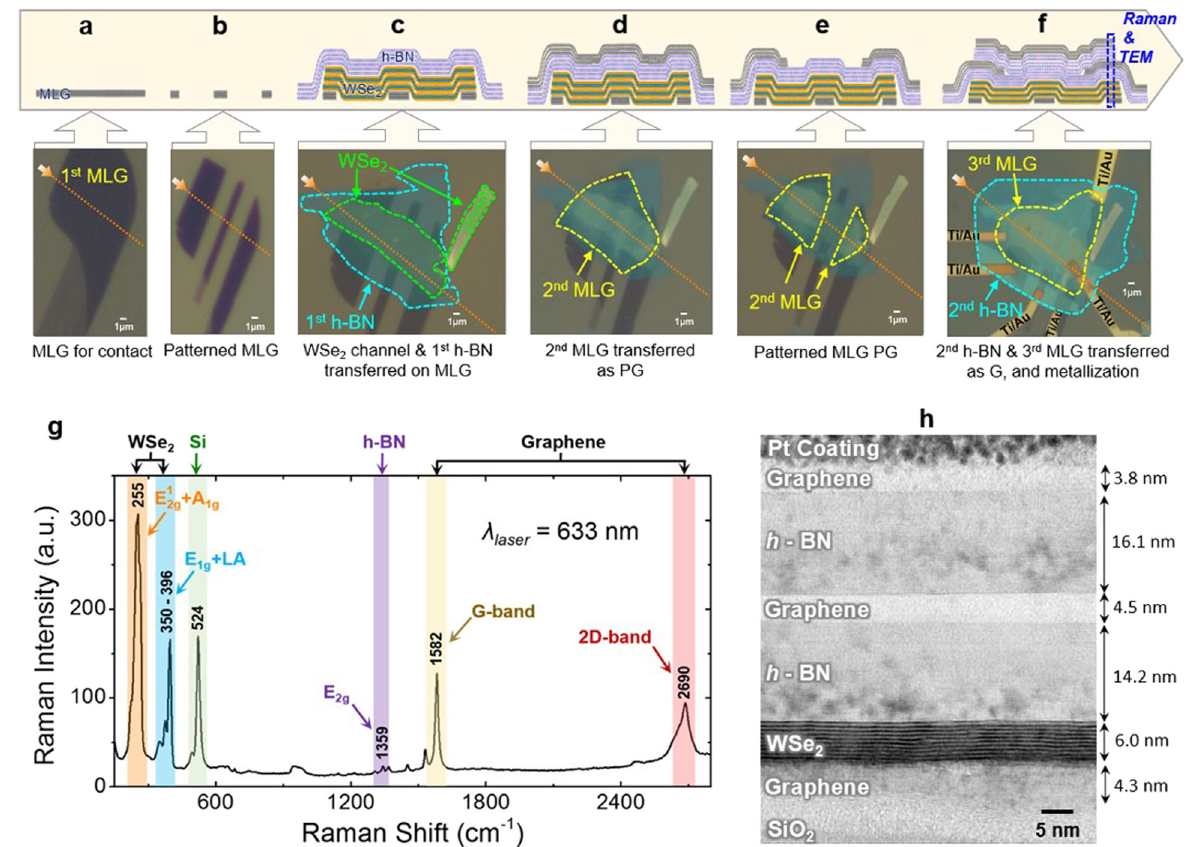
Fig. 2 Fabrication fl ow and structural characterization of the designed all-2D recon fi gurable logic gate. Cross-sectional schematics ( a – f ) and optical microscope images ( g , h ) of primary fabrication fl ow of designed vdW strata, and characterization. The starting piece of MLG in a is etched into three contact electrodes in b , then WSe 2 fl ake (as channel) and fi rst h -BN (as PG dielectric) are transferred on the MLG contacts in c . The WSe 2 fl ake not covered by h -BN is thick and unused. Second MLG is transferred as PG in d and then etched to uncover the channel part in e . Ti/Au (10/90 nm) metallization is carried out on the MLG contacts and PGs. Final step involves the third MLG and second h -BN transferred as gate stack, and Ti/Au (10/90 nm) metallization to the MLG gate in f . The brown arrows and dotted guide lines in the microscope images (second row) show the location of cross sectional schematics in the fi rst row. g Raman characterization of the fabricated vdW strata at the location marked with the blue dashed rectangle in f , further corroborating the desired materials in the strata and their good quality. h Transmission electron microscopy (TEM) imaging also at the location marked with the blue dashed rectangle in f , verifying a faithful reproduction of the original